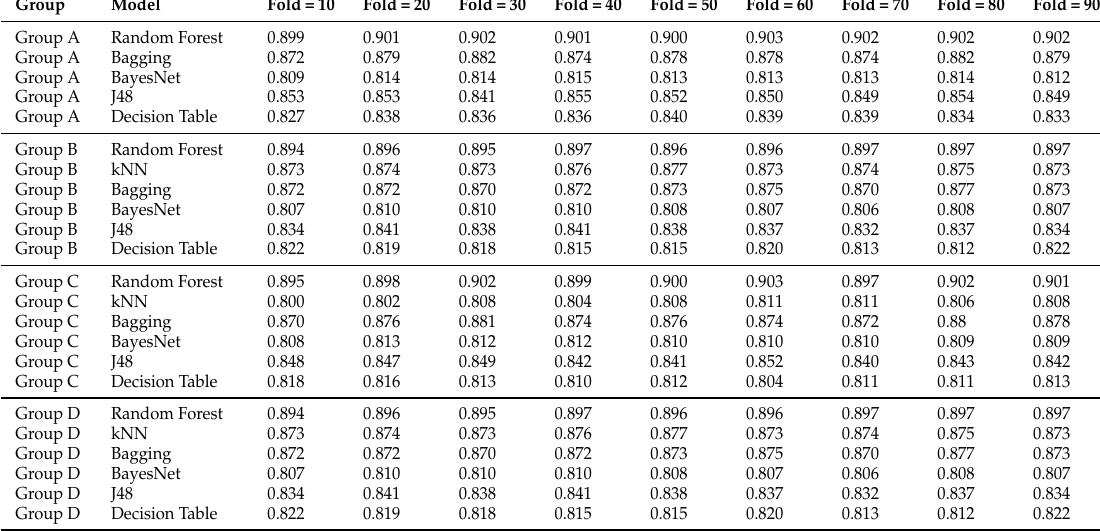
Table 7. Area under the Receiver Operating Characteristics (ROC) curve (AUC) using excellent